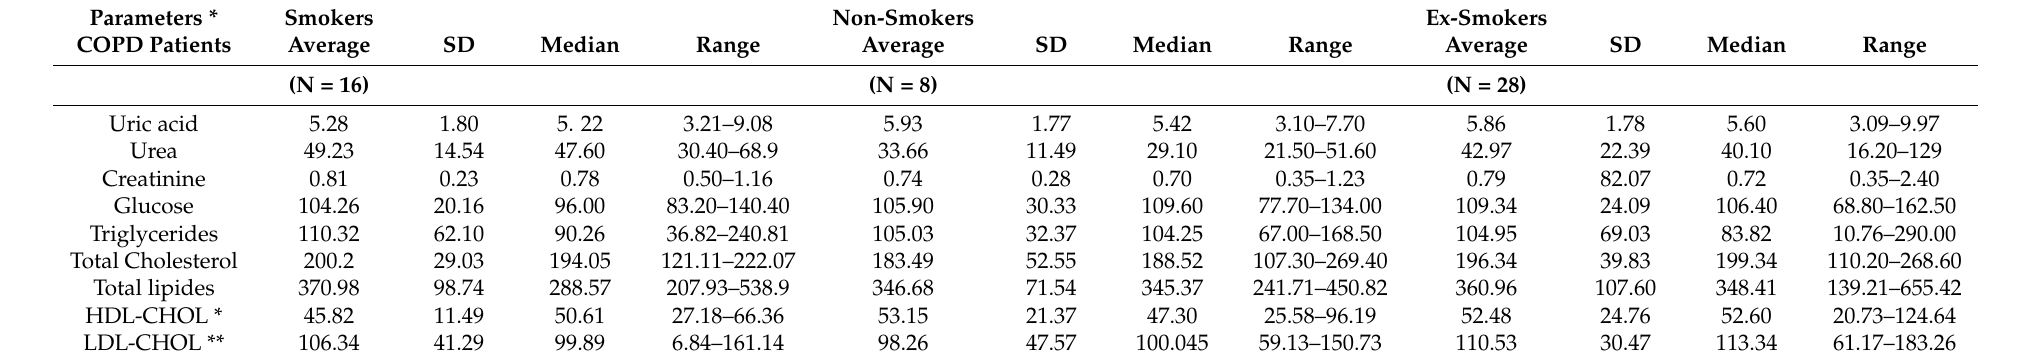
Table 2. Descriptive statistics of the biochemical parameters of the patients included in the study (all parameters are expressed in